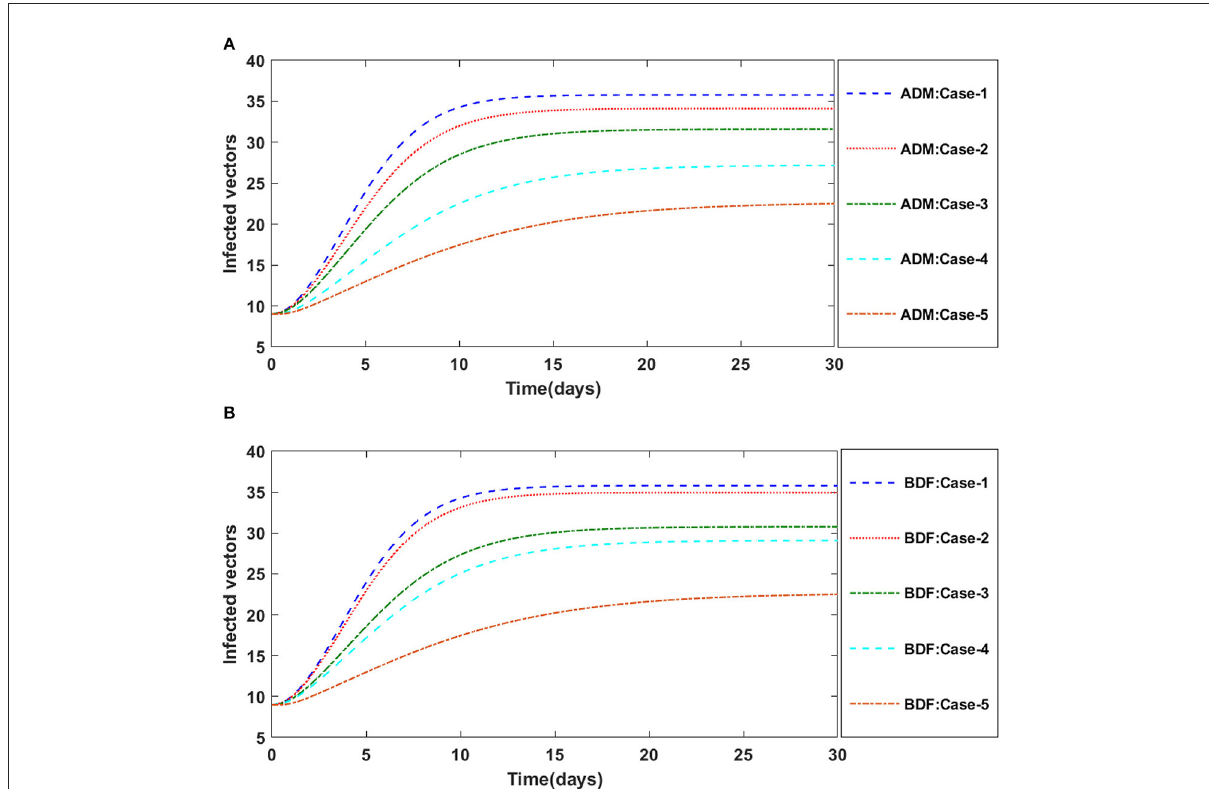
FIGURE17 (A) Dynamics of infected vectors for the varition in d using ADM for model B. (B) Dynamics of infected vectors for the varition in d using BDF for model